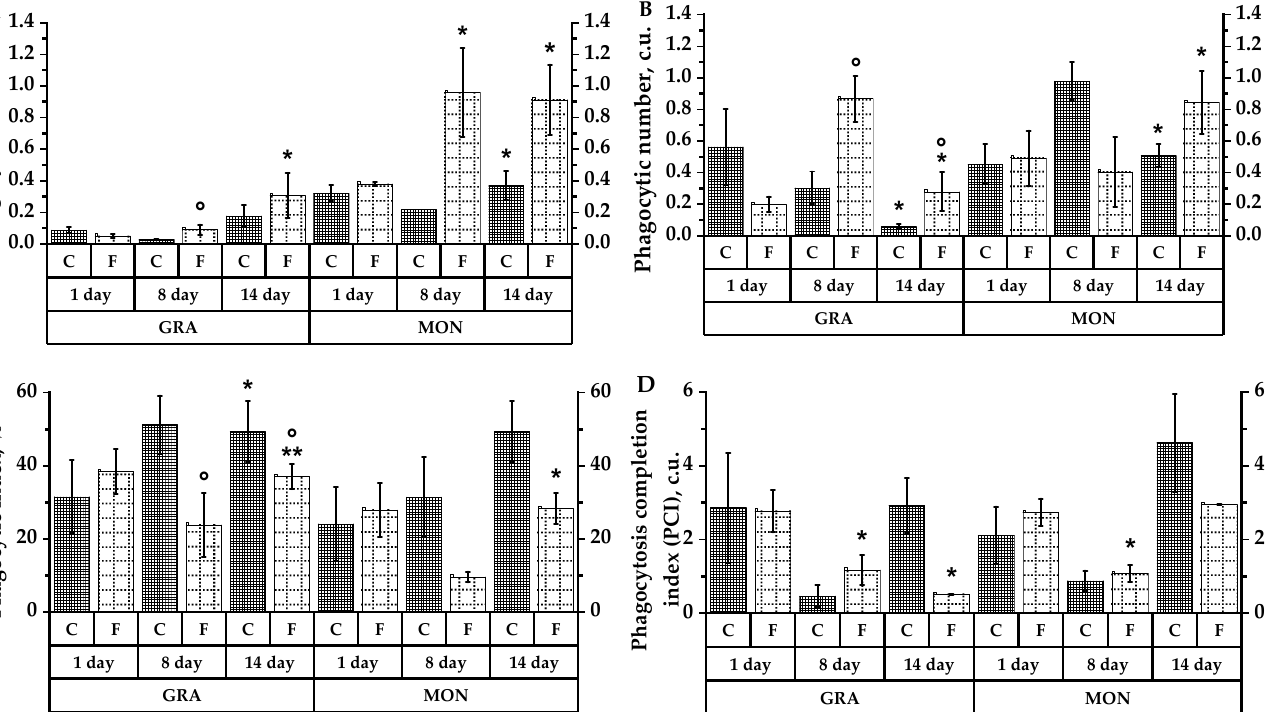
Figure 5. Indices of neutrophilic granulocyte and monocyte phagocytic activity in peripheral rat blood of groups C, D and F. Indices (phagocytic index ( A ); phagocytic number ( B )) are expressed in units; phagocytic index ( C ) is expressed in %; phagocytosis completion index ( D ) is expressed in conventional units (c.u.). * ( p < 0.05), ** ( p < 0.01)—differences reliability compared to 1 experimental day; ° ( p < 0.05)—differences reliability between animal groups compared to the control group.